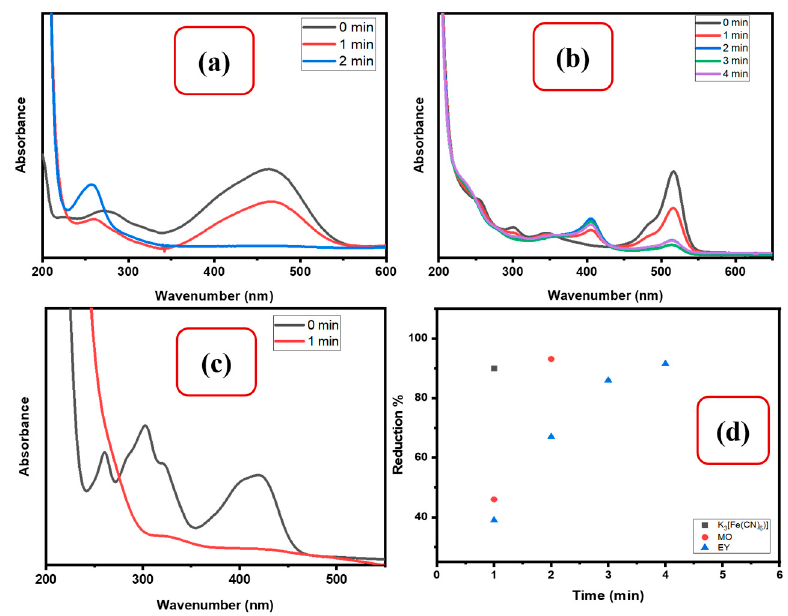
Figure 9. UV–Vis spectra for catalytic reduction of ( a ) MO, ( b ) EY, and ( c ) K 3 [Fe(CN) 6 ] using CMC/CuO-TiO 2 beads in the presence of NaBH 4 , ( d ) removal percentage of MO, EY, and K 3 [Fe(CN) 6 ] using 5 mg CMC/CuO-TiO 2 in the presence of NaBH 4 .